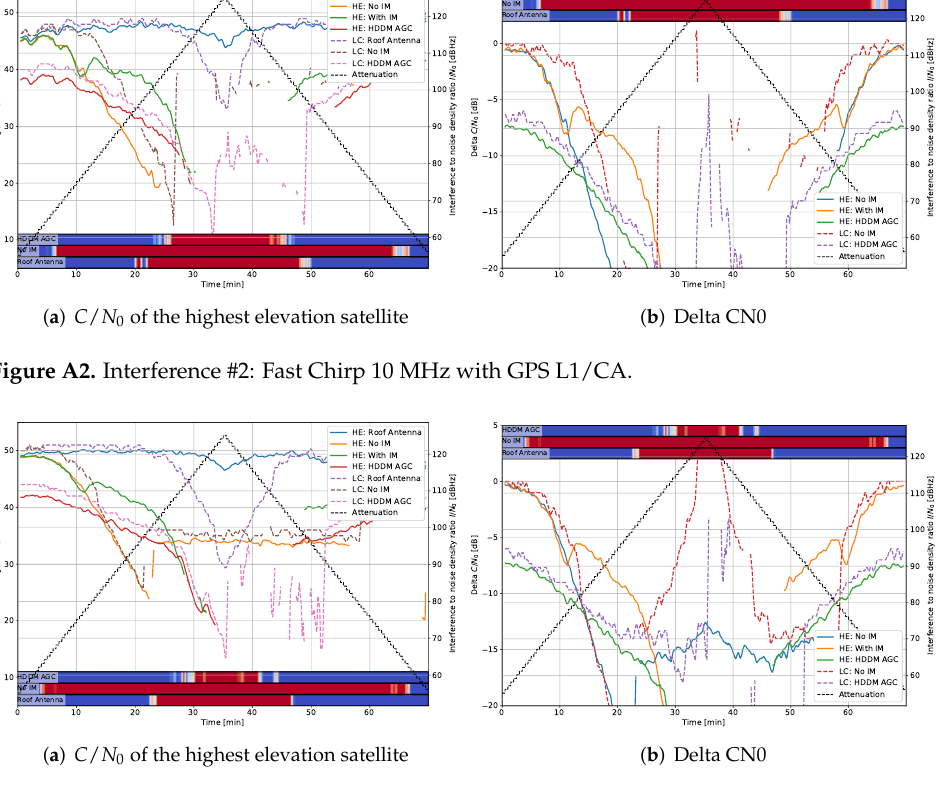
Figure A3. Interference #3: Slow Chirp 10 MHz with GPS